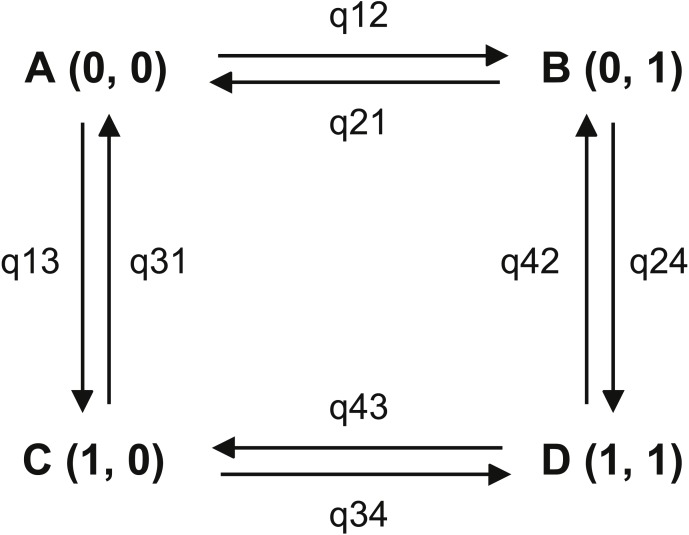
Transitions among the four combinations of traits states.The first trait is habitat, state 0 represents non-riparian habitat, state 1 represents riparian habitat; the second trait is leaf shape, state 0 represents leaf shape index > 0.15, state 1 represents leaf shape index ≤ 0.15. (A) non-narrowly lanceolate leaf in non-riparian habitat; (B) narrowly lanceolate leaf in non-riparian habitat; (C) non-narrowly lanceolate leaf in riparian habitat; (D) narrowly lanceolate leaf in riparian habitat.